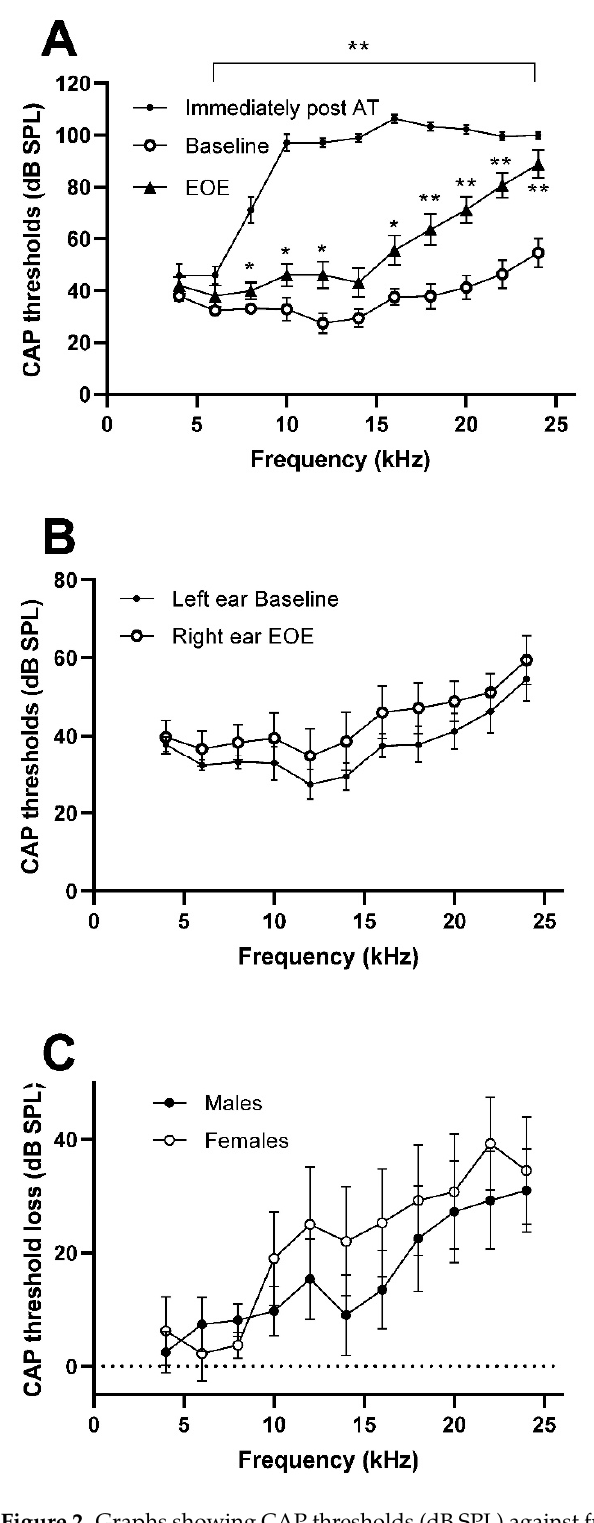
Figure 2. Graphs showing CAP thresholds (dB SPL) against frequency to demonstrate the effect of AT. ( A ): Before AT (baseline; n = 13), immediately after the AT ( n = 13) and at the end of experiment (EOE; n = 12). ( B ): Left ear (AT side) before AT and right ear at EOE, showing normal thresholds ( n = 13). ( C ): EOE thresholds of males ( n = 9) and females ( n = 4). All mean ± SEM. * p < 0.05; ** p < 0.01.